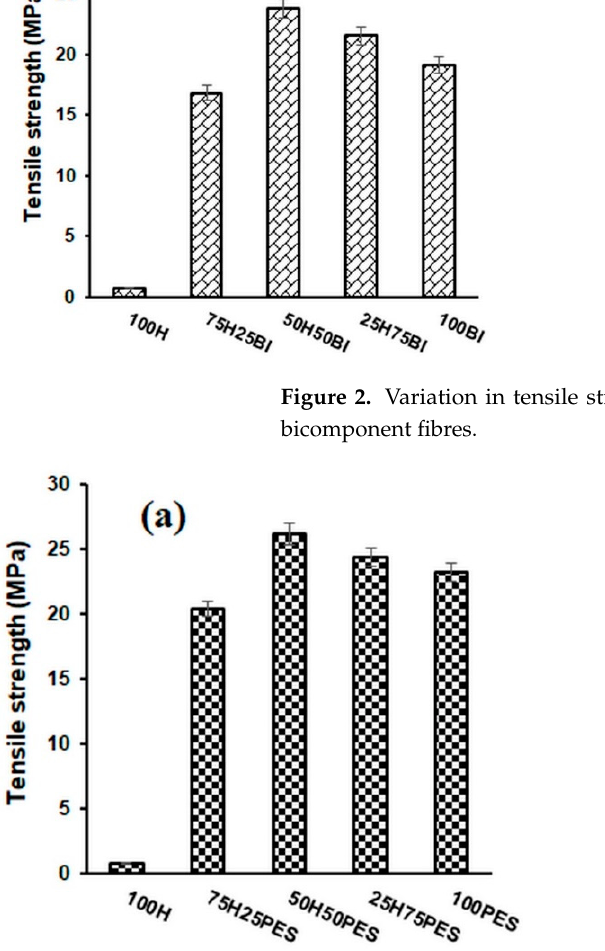
Figure 3. Variation in tensile strength ( a ) and elongation at break ( b ) for composite materials of hemp and polyester fibres.